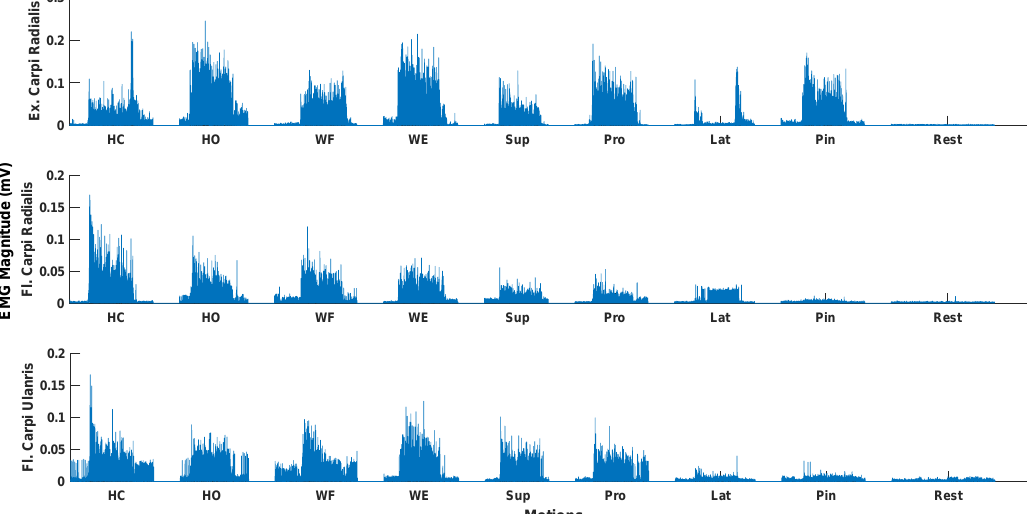
Figure 1. Rectified (only for visualization) and bandpass filtered surface EMG for the nine di ff erent motion classes for a single repetition and a single participant. Hand Close (HC), Hand Open (HO), Wrist Flexion (WF), Wrist Extension (WE), Supination (Sup), Pronation (Pro), Lateral Grasp (Lat), and Pin (Pinch Grasp). Flexor (Fl.), Extensor (Ex.). Clear EMG activity can be seen for most motion classes except the Lateral